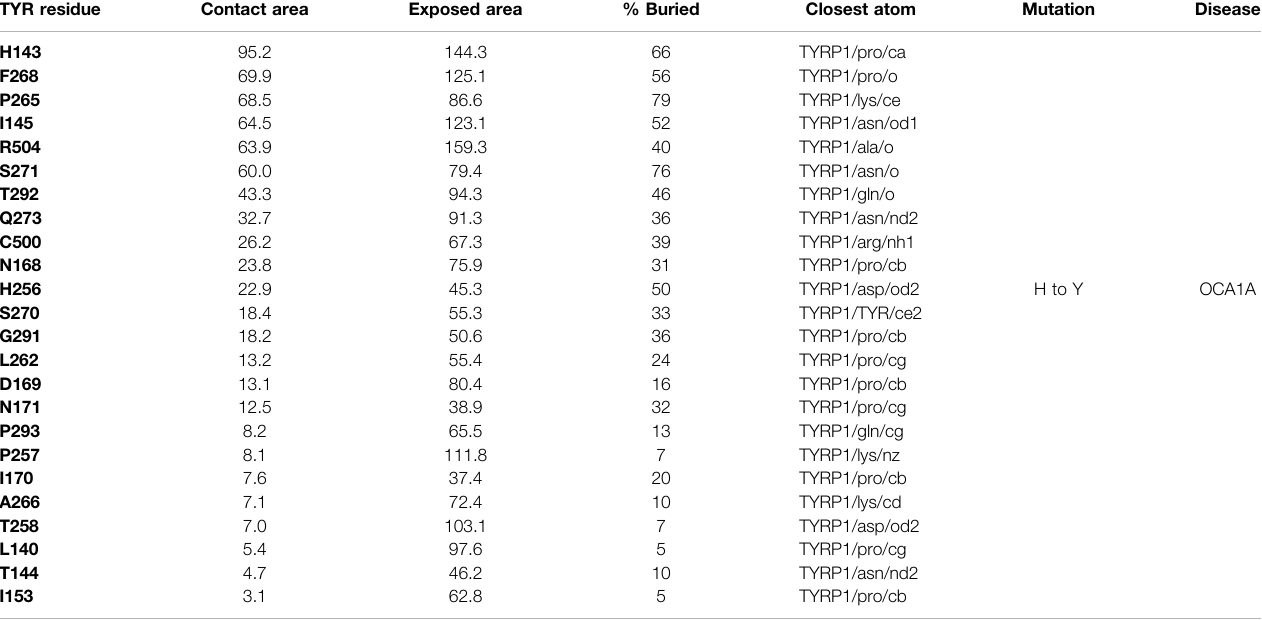
TABLE 1 | Residue contacts at the TYR-TYRP1 binding interface. Contact residues on TYR are ranked by decreasing strength of interactions, which is determined by a combination of the contact area, exposed area, the percentage of contact area compared to exposed (% buried) and closest distance to the atom on TYRP1. TYR